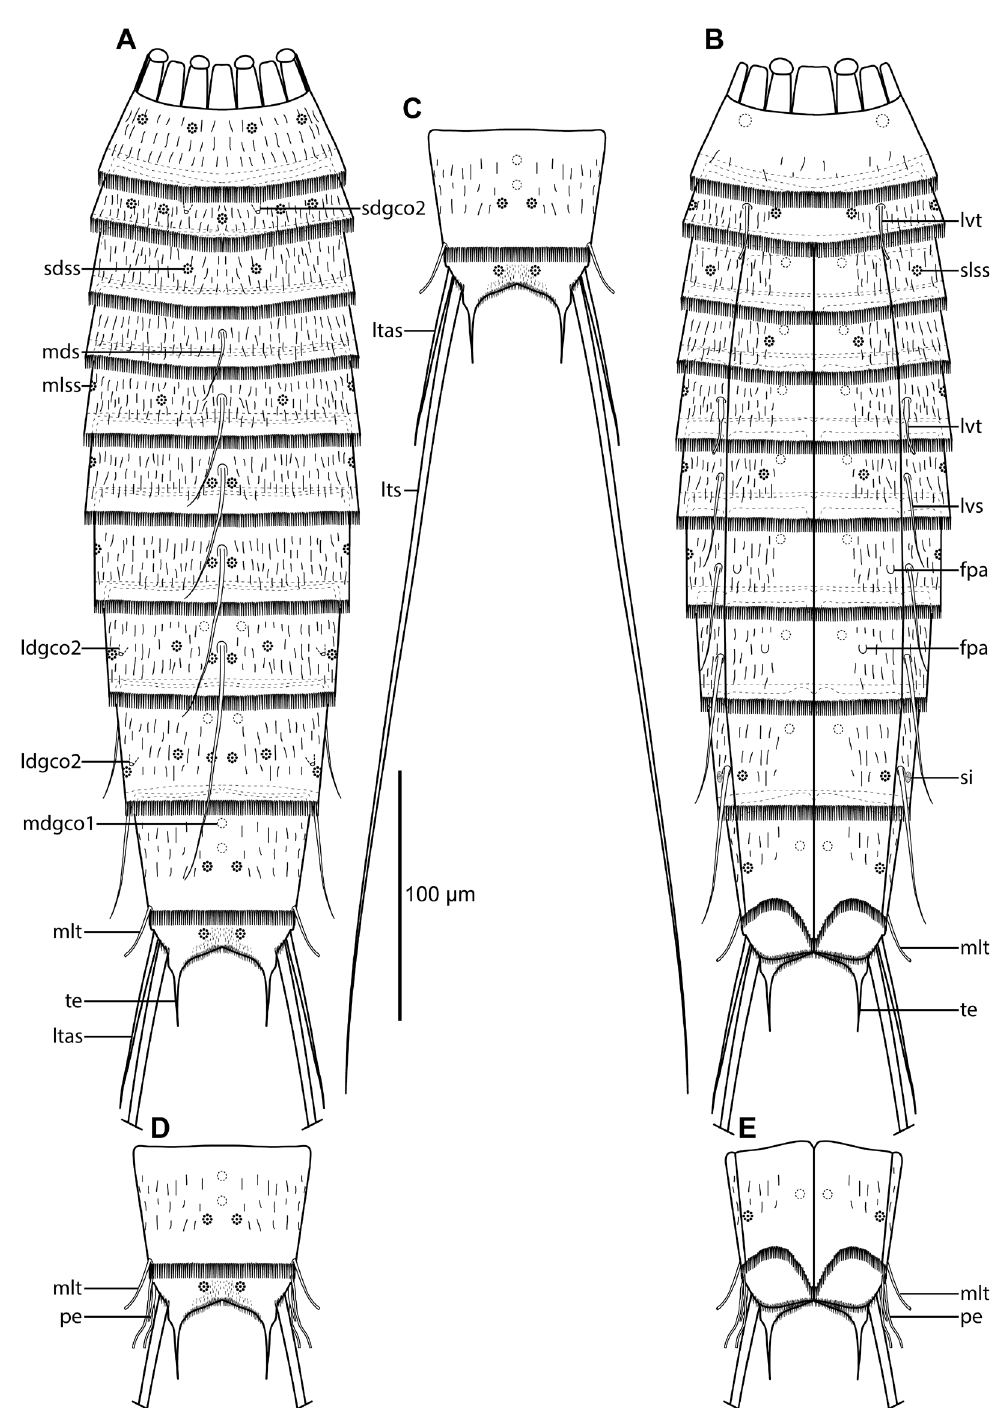
Fig. 18. Line art illustrations of Echinoderes lupherorum sp. nov. A . ♀, dorsal view. B . ♀, ventral view. C . ♀, segments 10 to 11, with lateral terminal spines drawn in full length, dorsal view. D . ♂, segments 10 to 11, dorsal view. E . ♂, segments 10 to 11, ventral view. Abbreviations: fpa = female papillae; ldgco2 = laterodorsal glandular cell outlet type 2; ltas = lateral terminal accessory spine; lts = lateral terminal spine; lvs = lateroventral spine; lvt = lateroventral tube; mdgco1 = middorsal glandular cell outlet type 1; mds = middorsal spine; mlss = midlateral sensory spot; mlt = midlateral tube; pe = penile spines; sdgco2 = subdorsal glandular cell outlet type 2; sdss = subdorsal sensory spot; si = sieve plate; slss = sublateral sensory spot; te =